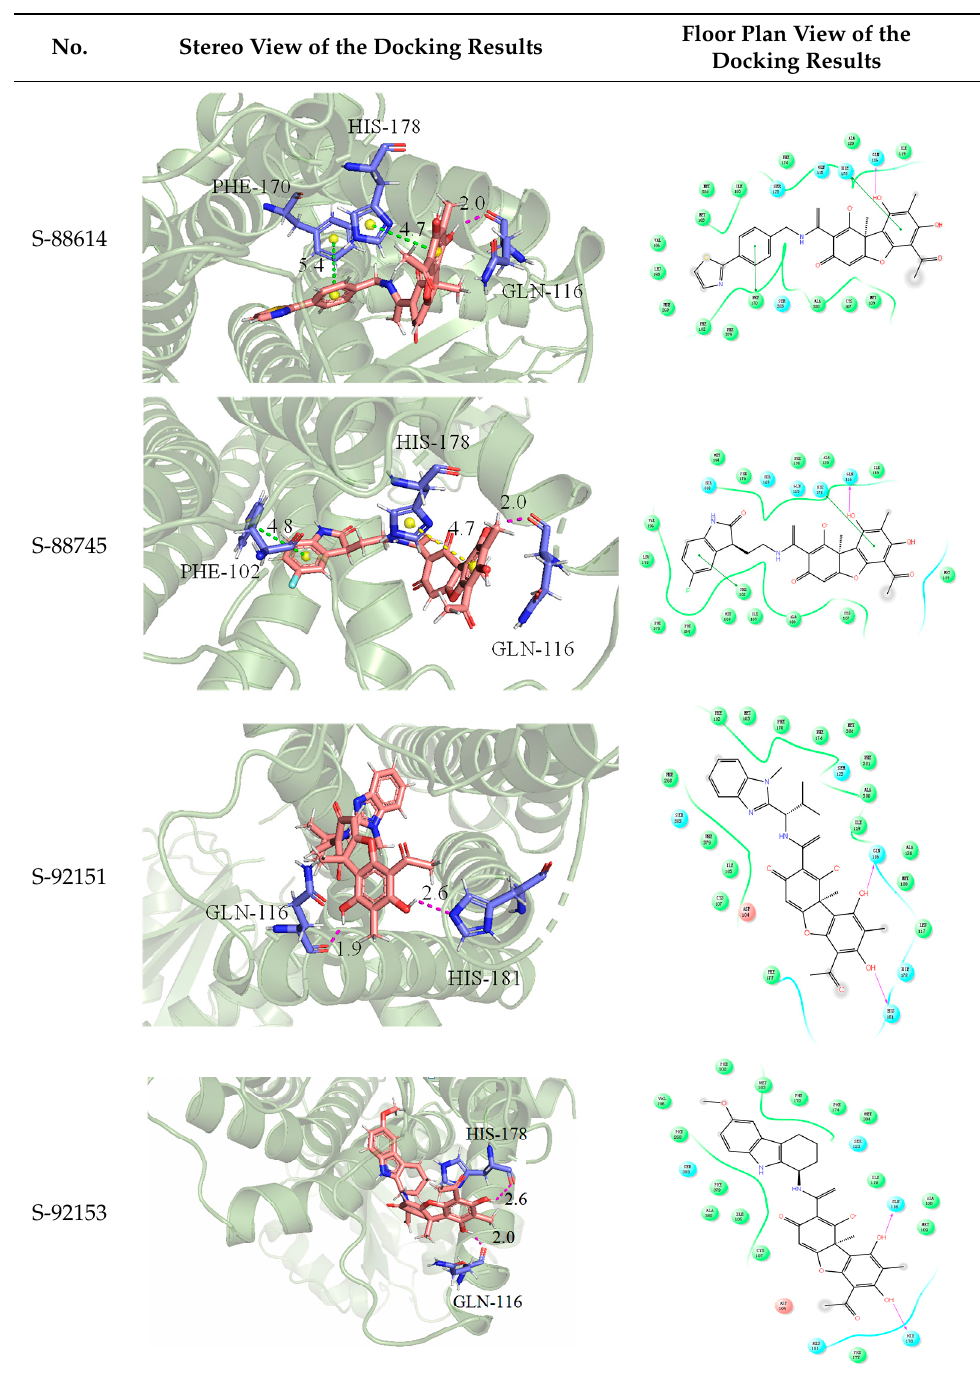
Table 2. Cont. No. Stereo View of the Docking